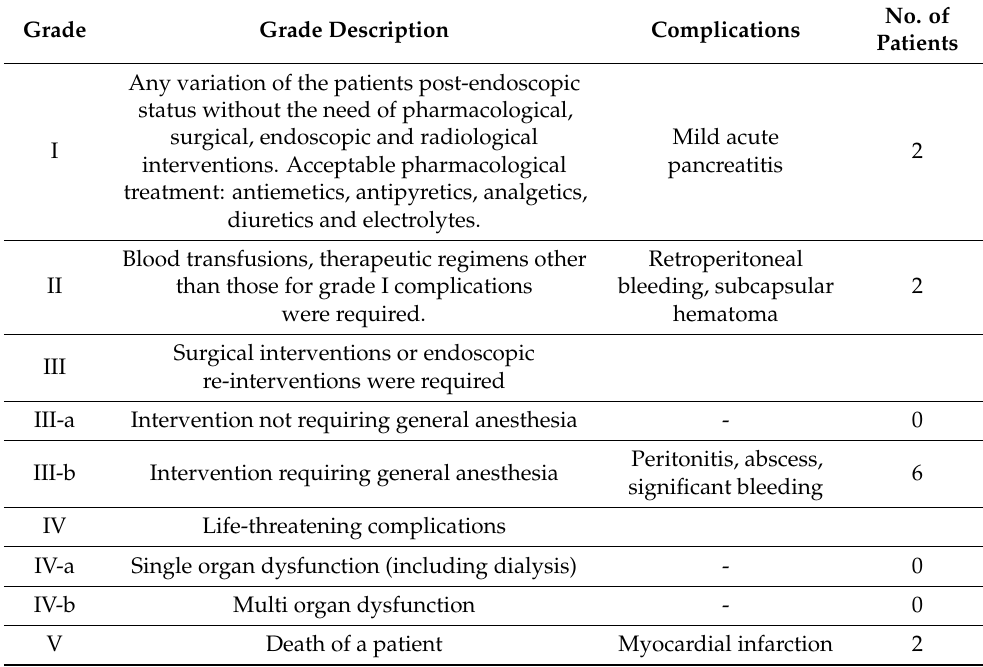
Table 5. Complications grading according to Clavien-Dindo classification